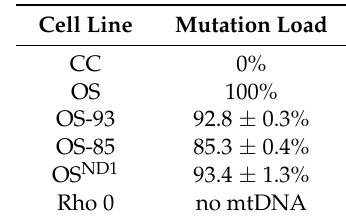
Table 1. Mutation loads for m.3571insC/ MT-ND1 mutation in cell models used in this study determined by F-PCR [20].